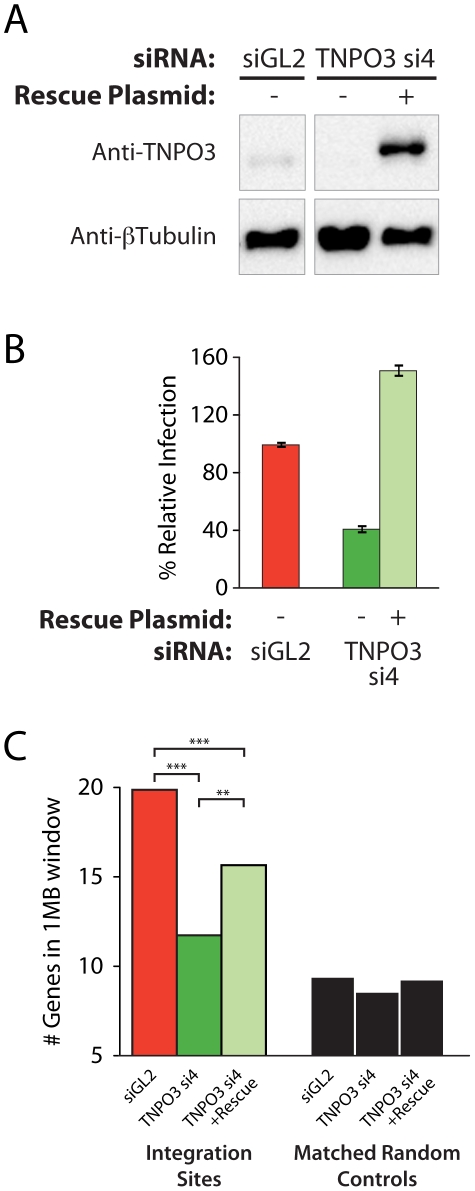
Transfection of a Transportin-3 allele insensitive to TNPO3 si4 restores protein expression, HIV infectivity, and partially restores wild-type HIV integration site distributions.(A) Western blot showing Transportin-3 levels in cells treated with TNPO3 si4 in the presence or absence of the Transportin-3 rescue plasmid. Cells were cotransfected with siRNA and either empty vector plasmid or rescue plasmid encoding siRNA-resistant alleles of Transportin-3 expressed from the CMV promoter and harvested at 48 hr post-transfection for analysis. Transportin-3 is reduced after co-transfection with siRNA and empty vector, and overexpressed after co-transfection with siRNA and rescue plasmid. Endogenous levels of Transportin-3 are shown in cells transfected with the control siRNA targeting GL2 and an empty vector. (B) HIV infection in cells treated with TNPO3 si4 in the presence or absence of the Transportin-3 rescue plasmid. Cells were co-transfected as above. 48 hr after transfection cells were infected with a VSVG-pseudotyped HIV-1 vector carrying a GFP reporter. At 48 hpi cells were harvested and the percent of cells expressing GFP was determined by flow cytometry. The Y-axis shows relative infection compared to infection in the control (GL2 siRNA + empty vector-transfected) cells. (C) Average gene density in 1 Mb windows surrounding HIV integration sites in cells depleted or rescued for Transportin-3 expression. Asterisks denote significant differences as determined by the Mann–Whitney test (*P<0.05; **P<0.01; ***P<0.001).